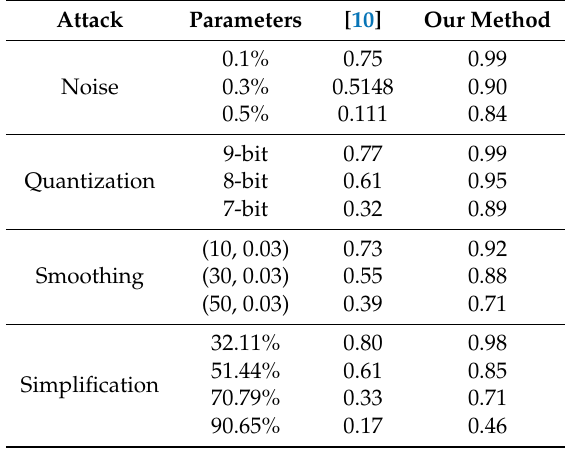
Table 22. Results of robustness comparison with Nakazawa et al.’s [10] method measured in terms of NC for the Bunny